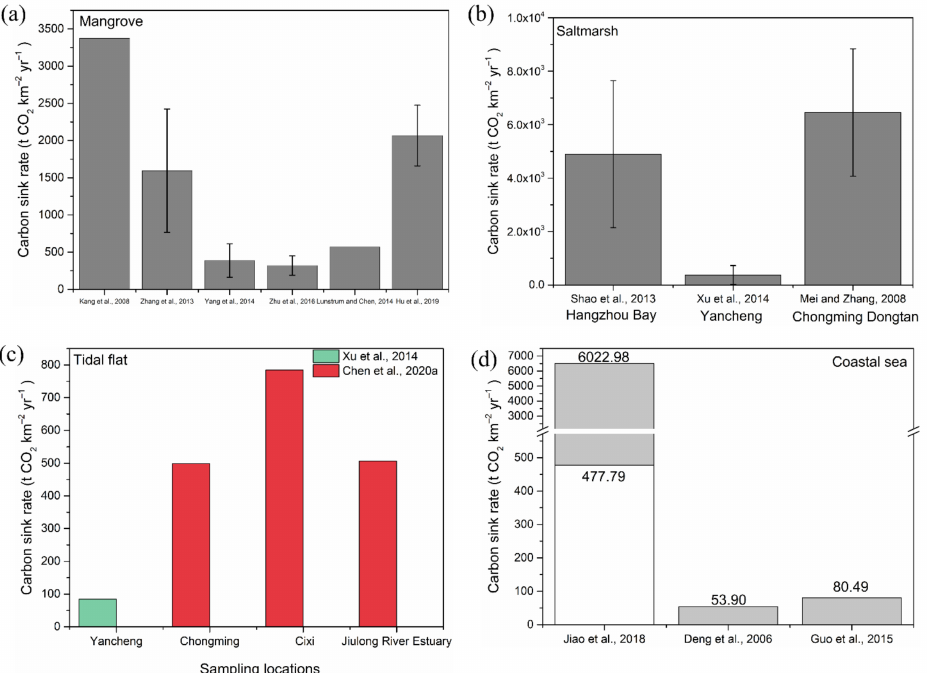
Figure 3. Carbon sink rates in marine and nearshore ecosystems from different studies. ( a ) Mangrove; ( b ) saltmarsh; ( c ) tidal flat; ( d ) coastal sea. Source of data: Kang et al., 2008, carbon sequestered by the net productivity of mangroves in Guangzhou [32]; Zhang et al., 2013, carbon sink capacity of mangroves in different areas of China [33]; Yang et al., 2014, mangrove coasts of the Leizhou Peninsula, in Guangdong [34]; Zhu et al., 2016, mangrove wetland in Zhanjiang Gaoqiao, Guang- dong [35]; Lunstrum and Chen, 2014, Futian National Nature Reserve on Shenzhen Bay, in Shenzhen, Guangdong [36]; Hu et al., 2019, mangroves in Qi’ao Island, Guangdong [37]; Shao et al., 2013, the coastal wetland of three dominant marsh plants in Hangzhou Bay, Zhejiang [38]; Xu et al., 2014, soil organic carbon storage of the coastal wetlands and tidal flats in Yancheng, Jiangsu [39]; Mei and Zhang, 2008, Phragmites australis in the east beach of Chongming Island, Shanghai [40]; Chen et al., 2020a, tidal flats of Shanghai Chongming, Zhejiang Cixi, and Fujian Jiulong River estuary [31]; Jiao et al., 2018, carbon sink in the ECS (the East China Sea) based on net primary productivity [41]; Deng et al., 2006, sediment accumulation and carbon burial in the ECS [42]; Guo et al., 2015, air–sea CO 2 fluxes in the ECS [43].